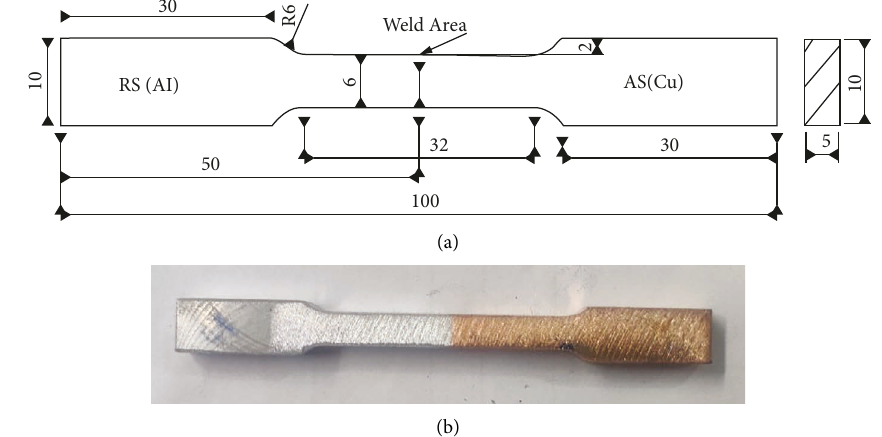
Figure 7: (a) Specimen geometry and (b) tensile test sample preparation.